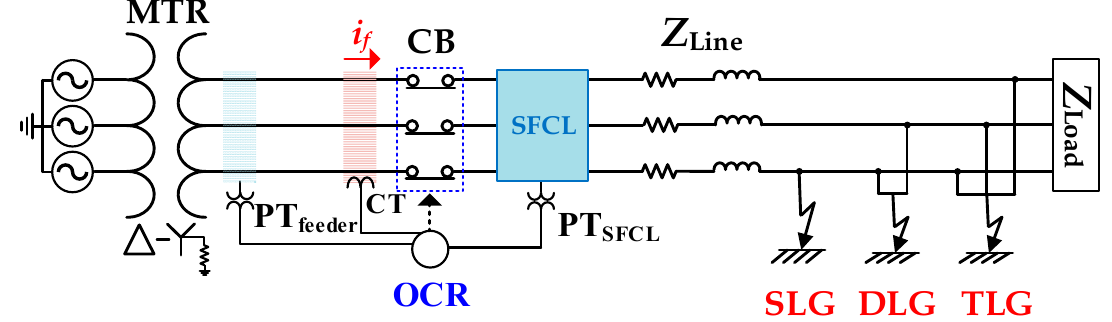
Figure 1. Structure of power distribution system with superconducting fault current limiter (SFCL). Table 1. Specifications of Power Distribution System.